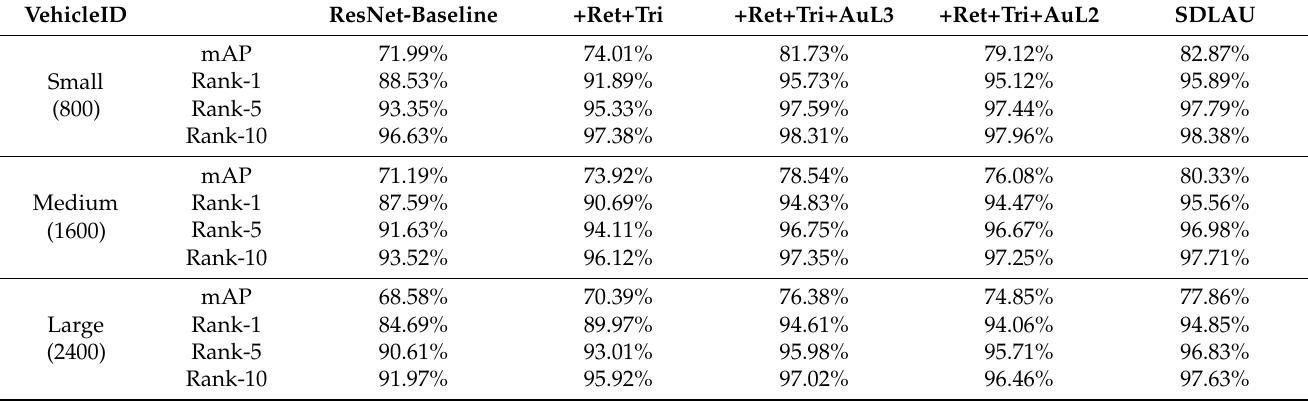
Table 3. Ablation study results on VehicleID